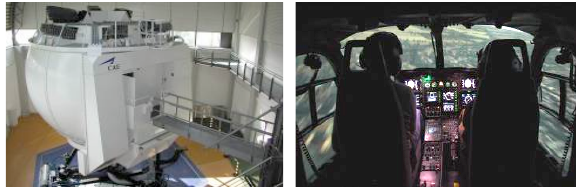
Figure 1. Helicopter Simulator with Glass Cockpit